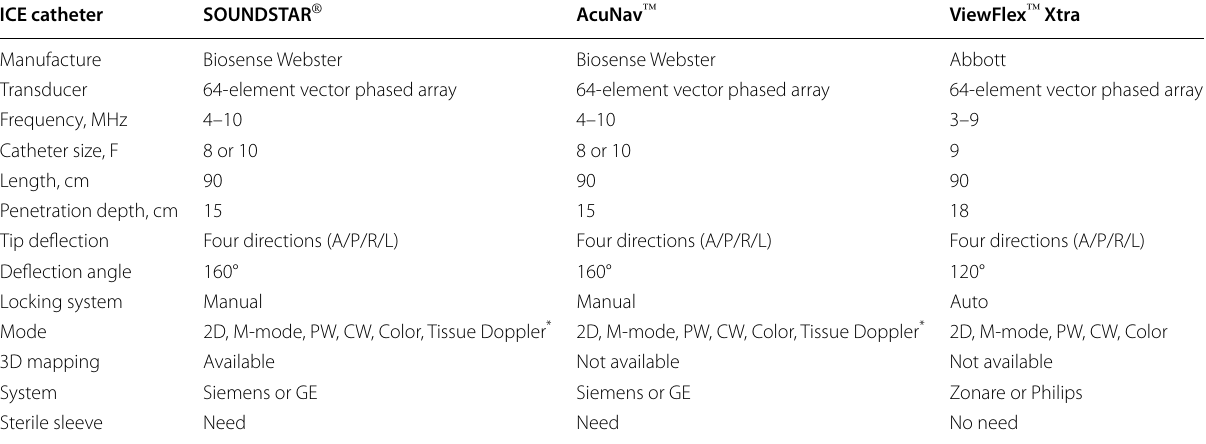
ICE intracardiac echocardiography, A anterior, P posterior, R right, L left, 2D, two-dimensional, PW pulse wave, CW continuous wave *